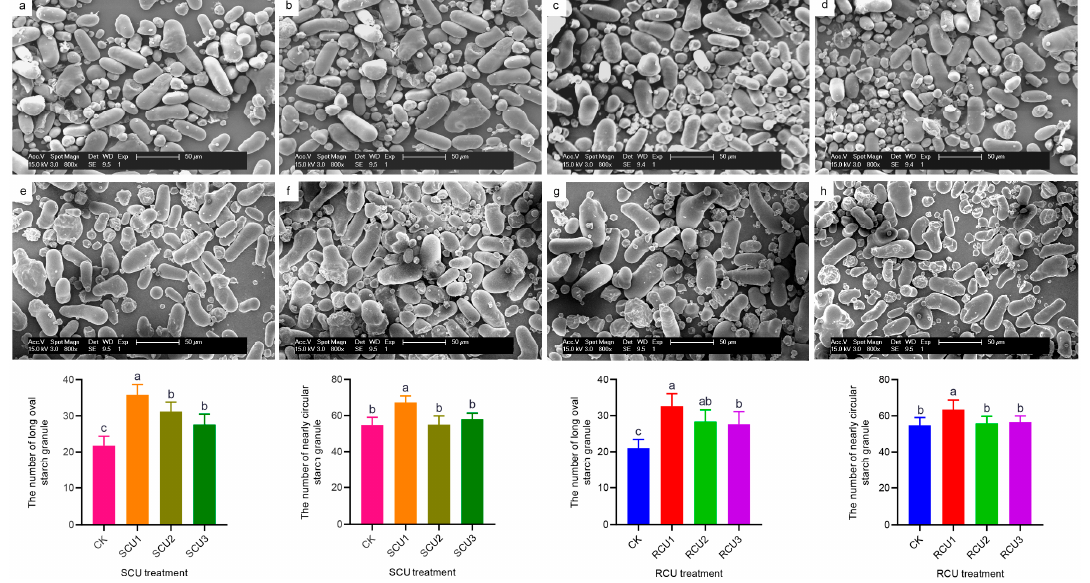
Figure 4. Effects of SCU and RCU on the morphology and the number of rhizome starch granules in the late swelling stage of lotus. ( a – d ) The granule morphology of starch under CK, SCU1, SCU2 and SCU3 treatments. ( e – h ) The granule morphology of starch under CK, RCU1, RCU2 and RCU3 treatments. Different letters indicate a significant difference in starch granule at the late swelling stage of the lotus rhizome between different treatments at the 5% level. We analyzed the photos to count the long oval and round granules. We analyzed the data using IBM SPSS 26.0 software for each sample of ten biological replications. Error bars show standard deviation (SD) from ten biological